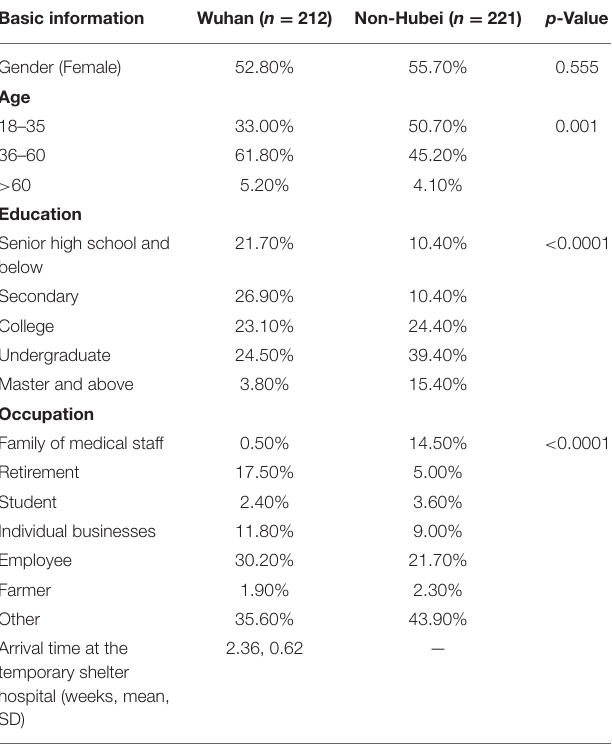
TABLE 2 | General information of interviewees on